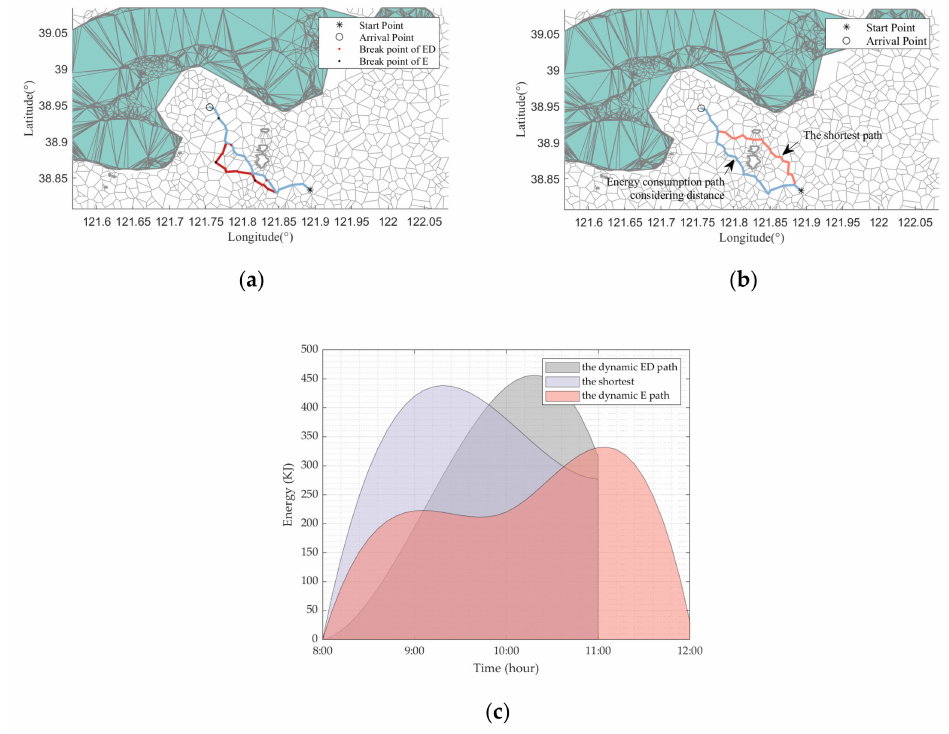
Figure 15. ( a ) Comparison between hourly dynamic energy-efficient path considers the distance and hourly minimal energy-consuming path. ( b ) Comparison between hourly dynamic energy-efficient paths considers the distance and the shortest path; ( c ) represents the energy consumption over time of three